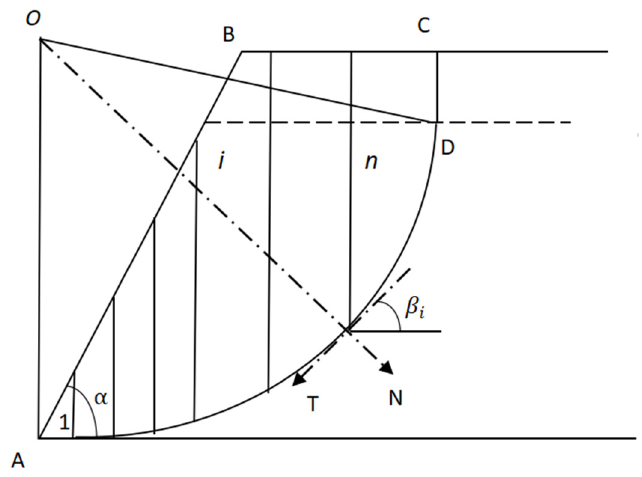
Figure 15. The calculation model of the slicing method. The tangential force pointing downhill along the sliding surface is also called the sliding force, the force pointing uphill is also called the anti–slip force, and the anti–skating force can be obtained from the normal force. When the sliding force is less than the anti–sliding force, the slope is stable; on the contrary, slope slip will occur. (4) Identify the location of ground fissures. From the valley of the slope, along the uphill direction of the slope, calculate the sliding force and the anti–sliding force of each strip one by one, and add them up one by one; take the ratio denoted as K , as shown in Equation (19).